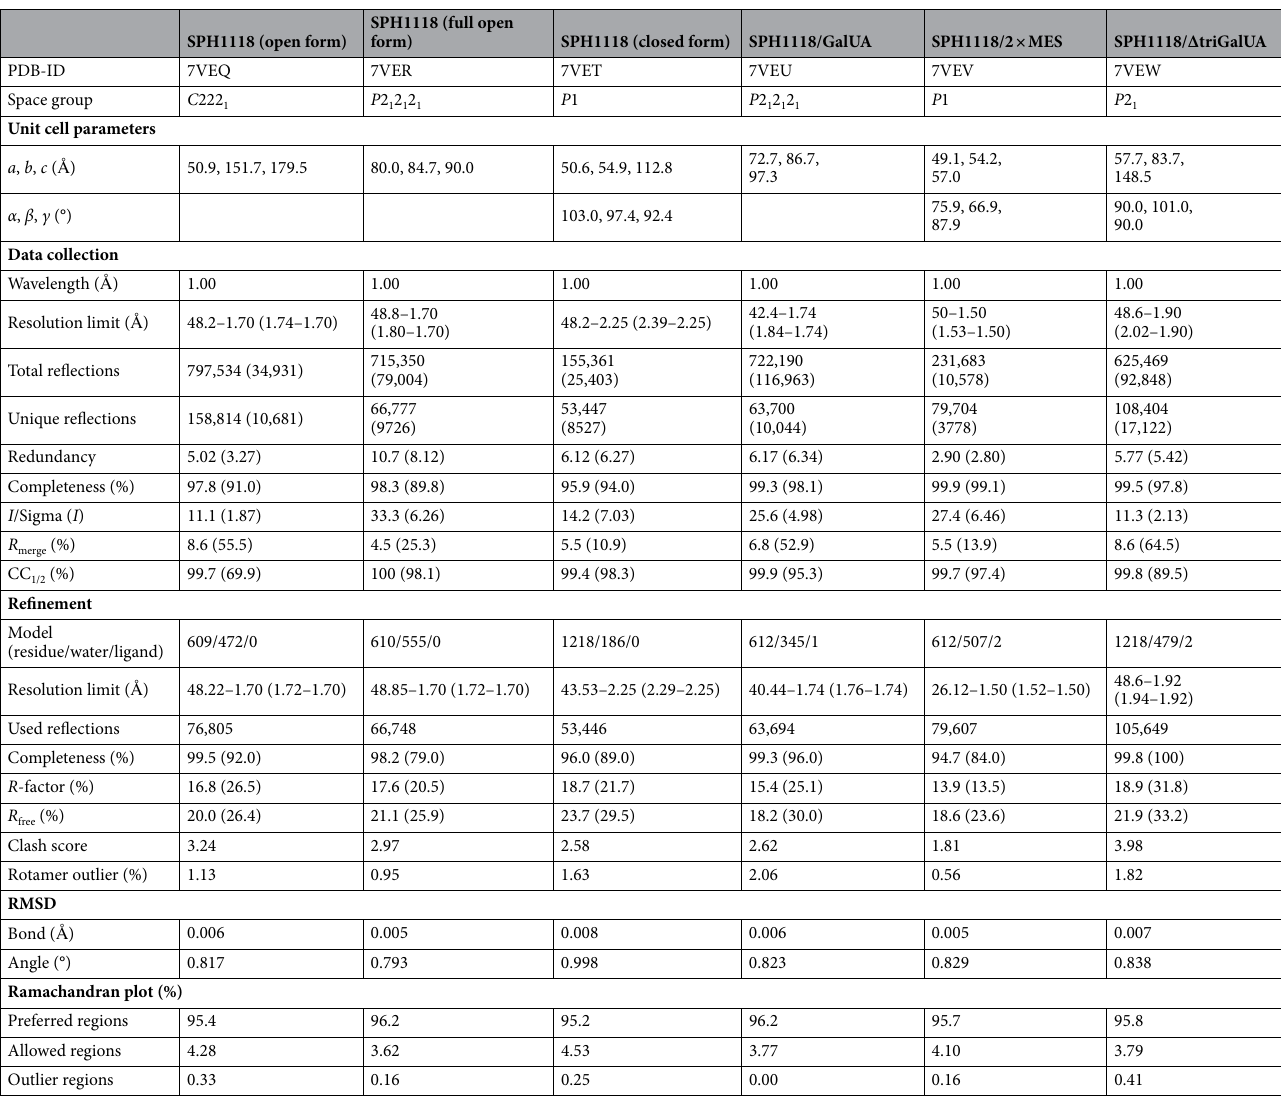
Table 1. Data collection and refinement statistics. Data of the highest shells are given in